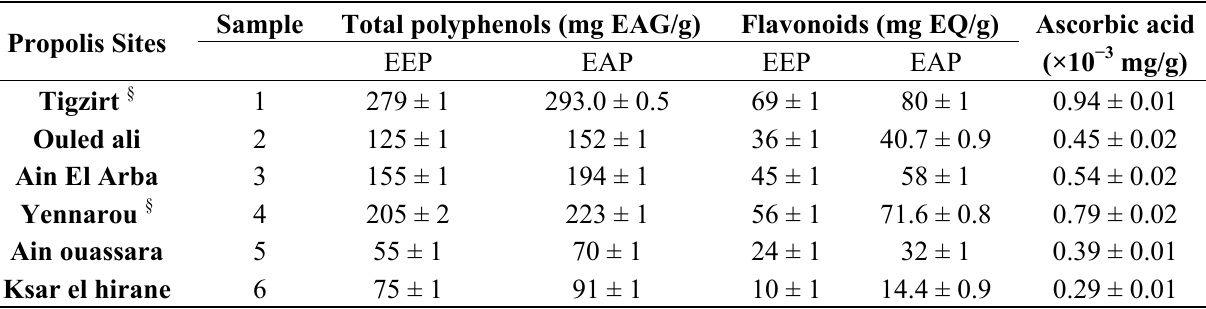
Table 1. Concentrations of polyphenols (Equivalent Acid Gallic, EAG), flavonoids (Equivalent Quercetin, EQ), and ascorbic acid in the ethanolic and ethyl acetate extracts of different types of propolis.